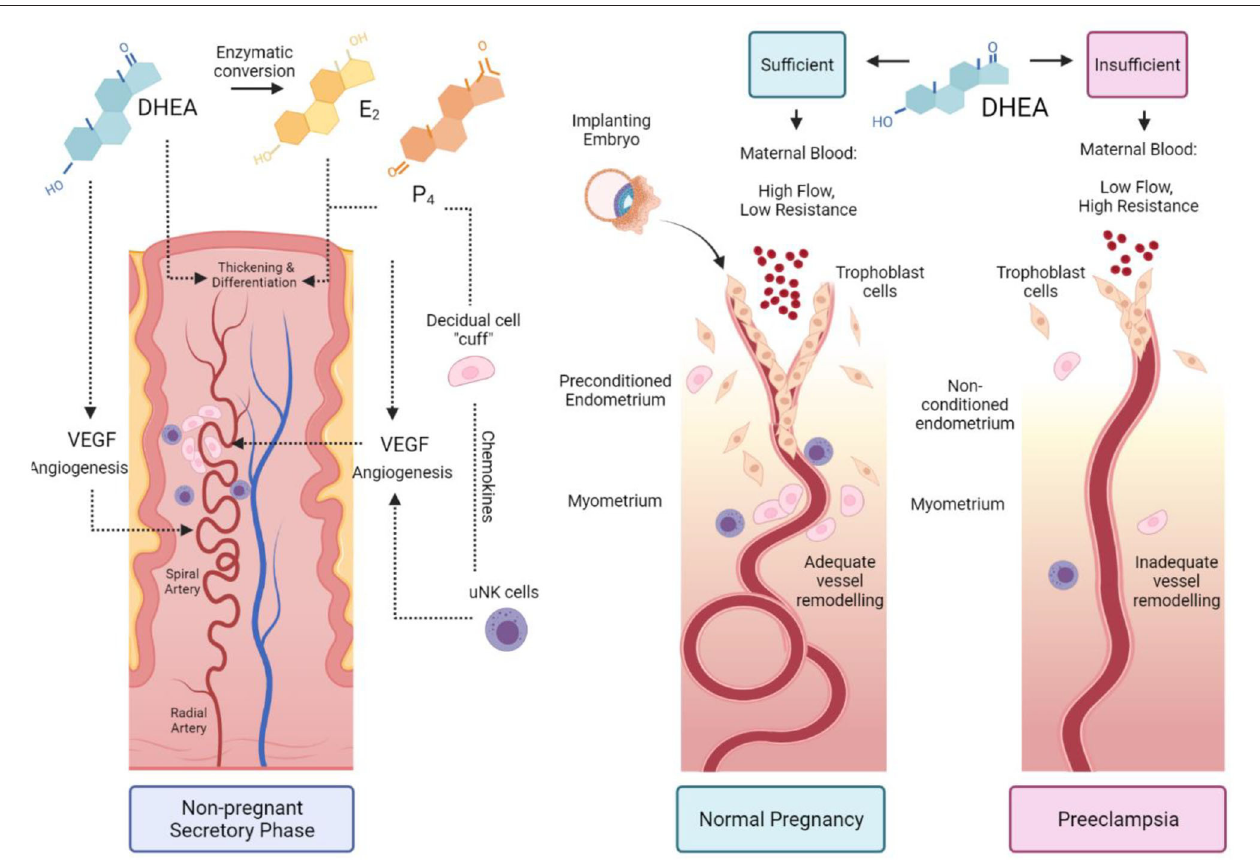
FIGURE 2 | The proposed role of DHEA in preconditioning the uterus for pregnancy. During the secretory phase of a normal menstrual cycle, DHEA acts via an androgen receptor or through conversion to oestrogen and through the oestrogen receptor to stimulate angiogenesis and spiral artery remodelling. Oestradiol (E 2 ) and progesterone (P 4 ) promote endometrial thickening and differentiation during spontaneous decidualisation. The decidual cells form a cuff around spiral arteries and recruit specialised uterine natural killer (uNK) cells to further promote vessel remodelling ( Left-hand panel ). Sufficient DHEA primes the uterus in the preceding menstrual cycles for embryo implantation. Trophoblasts invade through the remodelled vessels up to the myometrial layer and enable high maternal blood flow with low vascular resistance ( Middle panel ). Insufficient DHEA causes poor uterine preconditioning; low DHEA and reduced conversion to E 2 impairs decidualisation, uNK recruitment, angiogenesis and vessel remodelling. Trophoblast invasion is shallow, with high blood pressure due to vascular resistance, resulting in preeclampsia ( Right panel